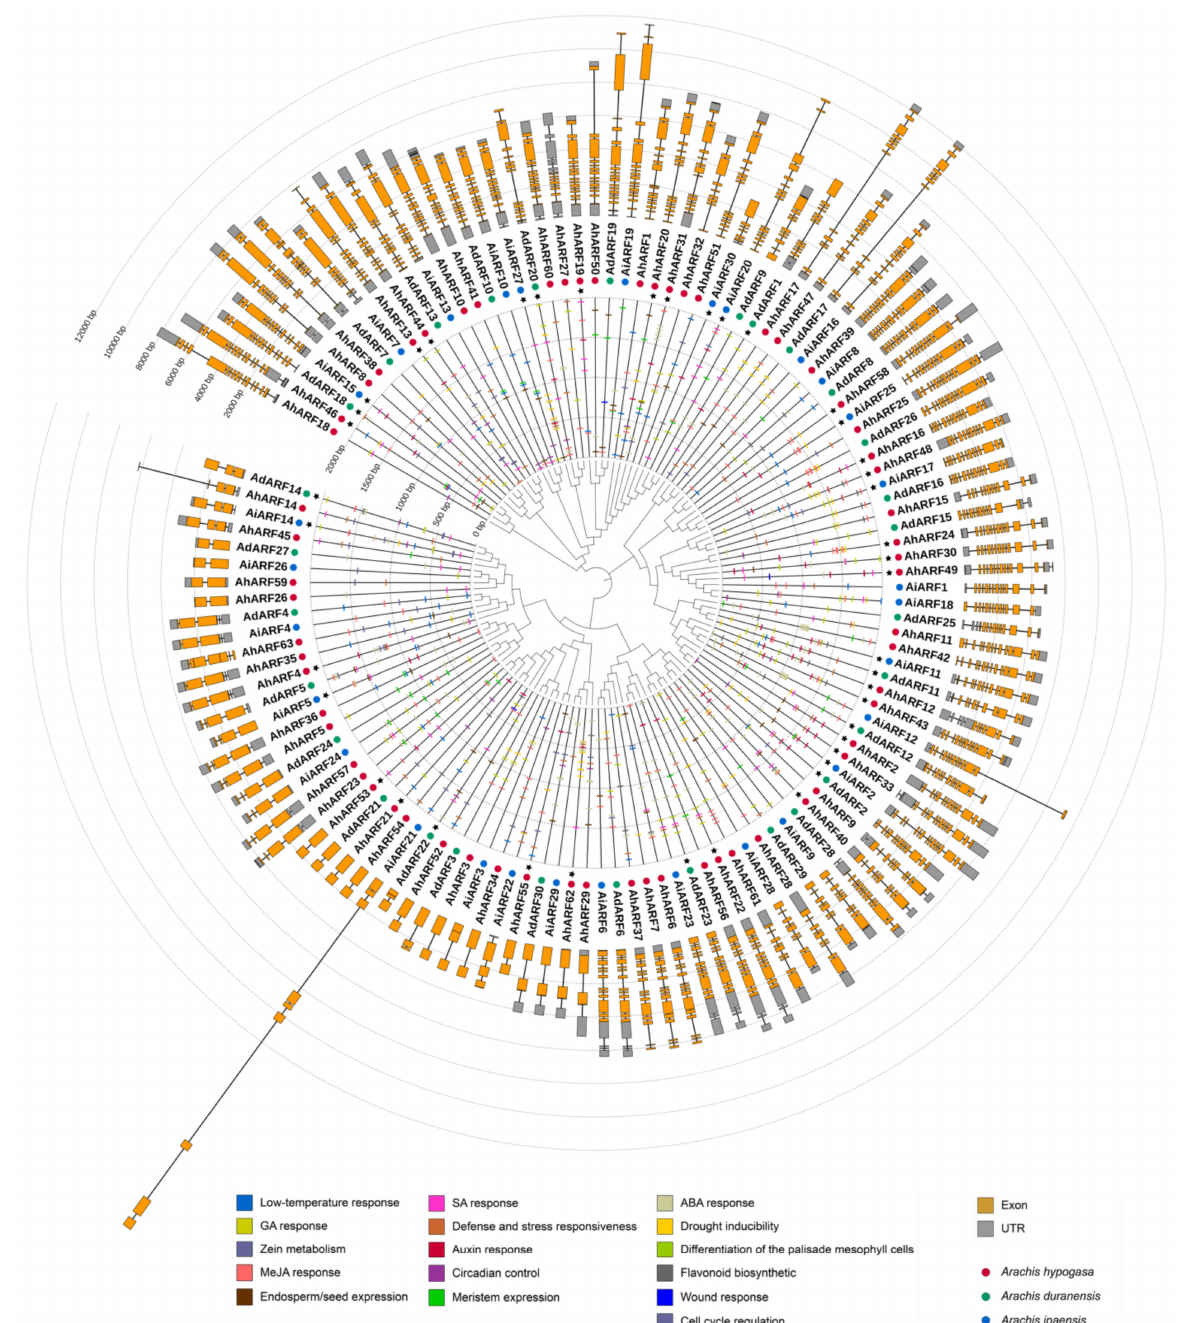
Figure 2. Phylogenetic tree, cis -elements, and gene structure analysis of ARF s in wild and cultivar peanuts. Gene structures are shown in the outer cycle, and cis -elements are shown in the cycle inside the gene names. The red, green, and blue dots represent AhARF s, AdARF s, and AiARF s,